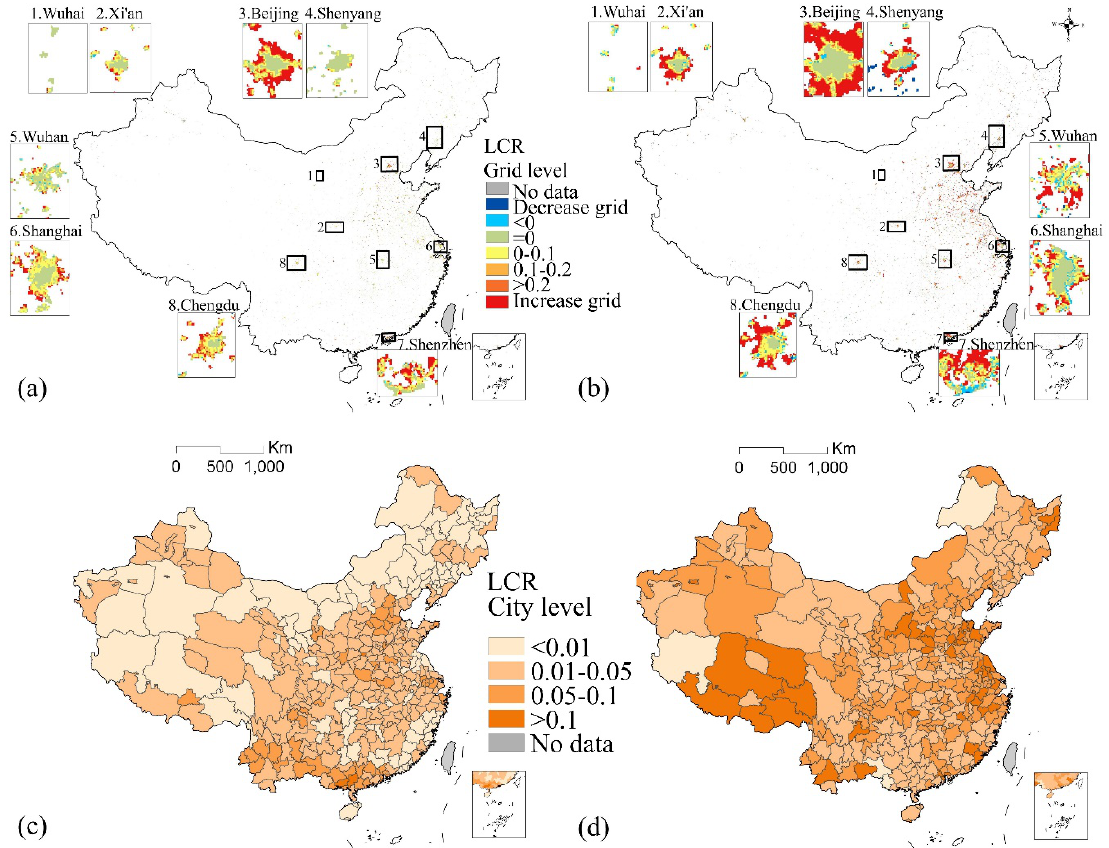
Figure 2. The LCR value in China in 1990–2010. ( a , b ) The spatial distribution of the LCR at 1 km × 1 km grid level; the increased grid indicates that the initial image has no built-up area in the grid and the final image has a built-up area in the grid, while the decrease grid means the opposite. ( c , d ) The spatial distribution of the LCR at the city level. ( a , c ) The LCR value in 1990–2000. ( b , d ) The LCR value in 2000–2010.